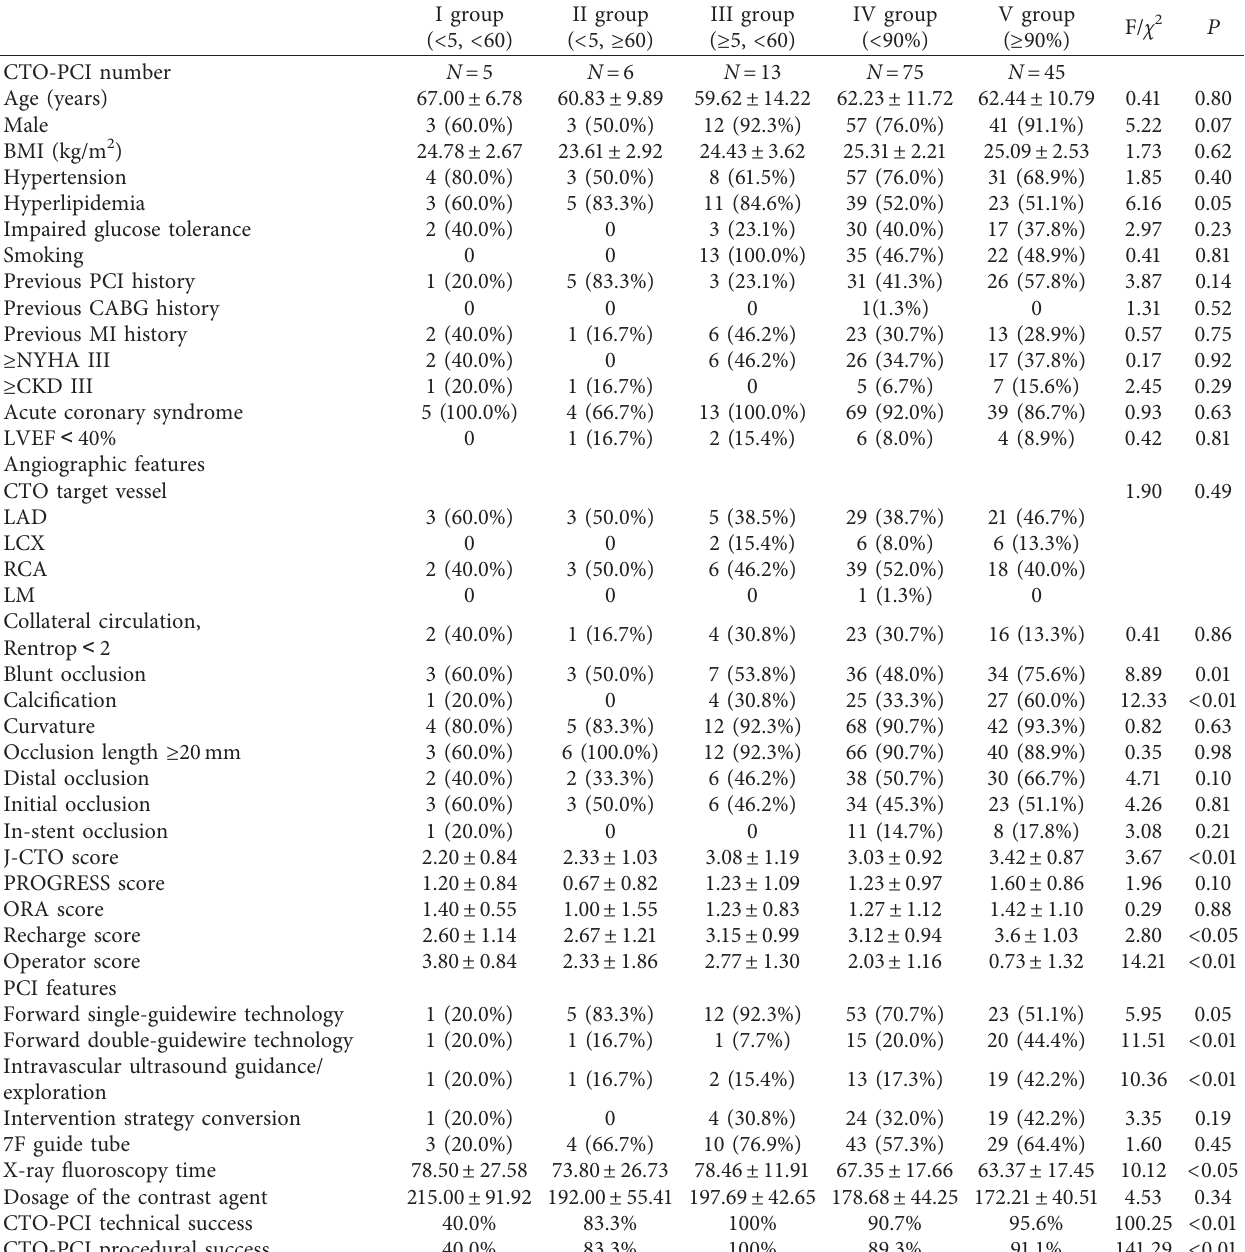
Table 7: Comparison of different CTO